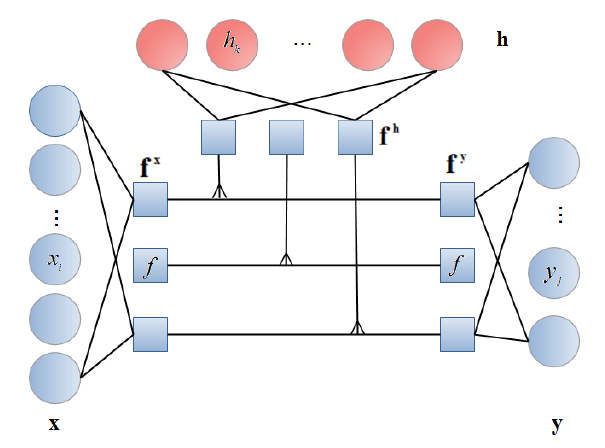
Figure 5. A simplified gated RBM introducing factor